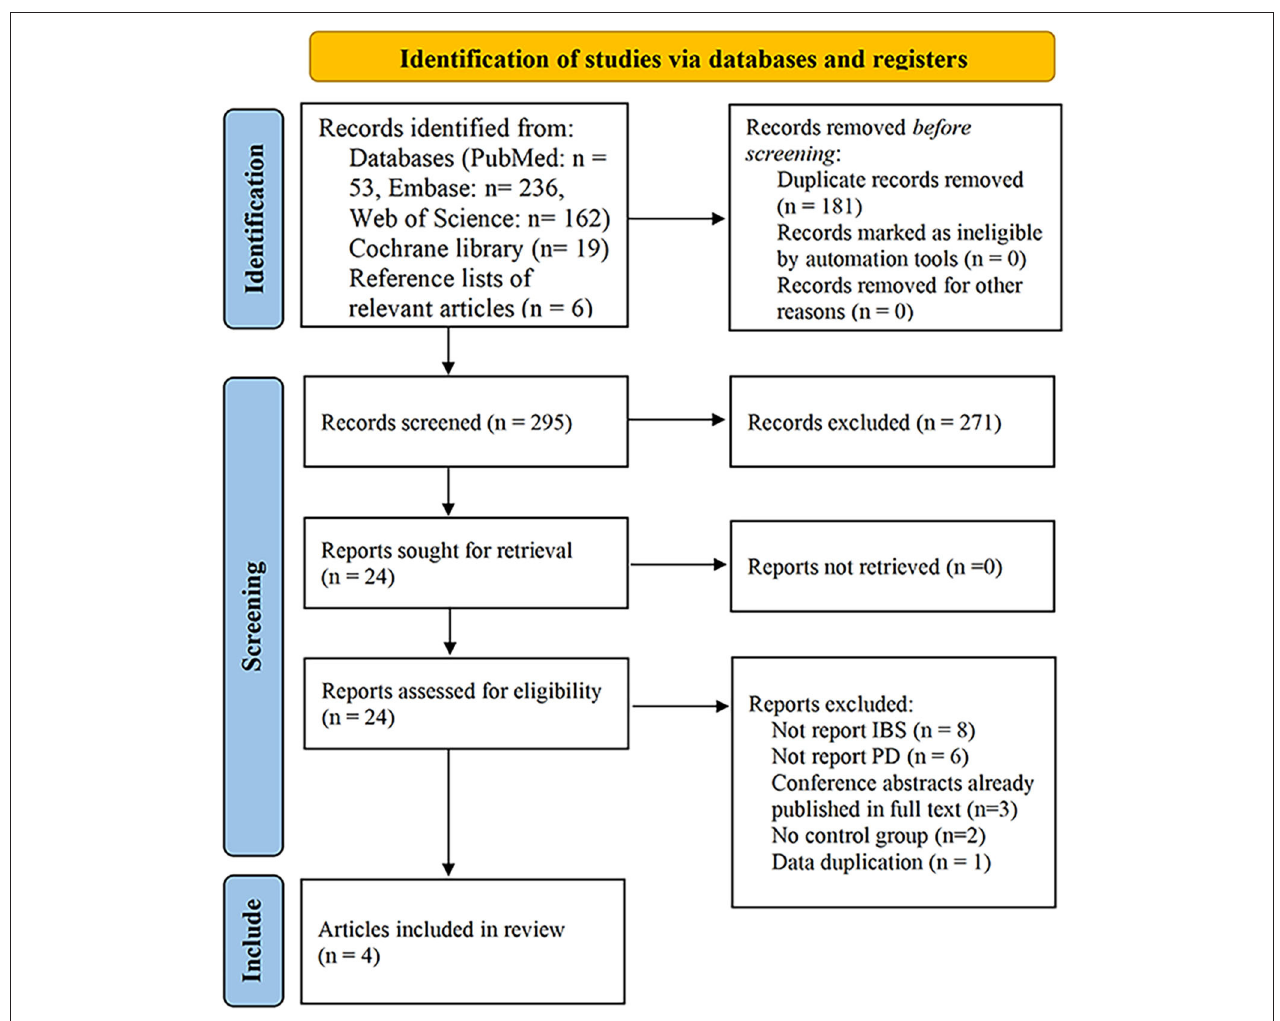
FIGURE 1 | Flow diagram of the study select